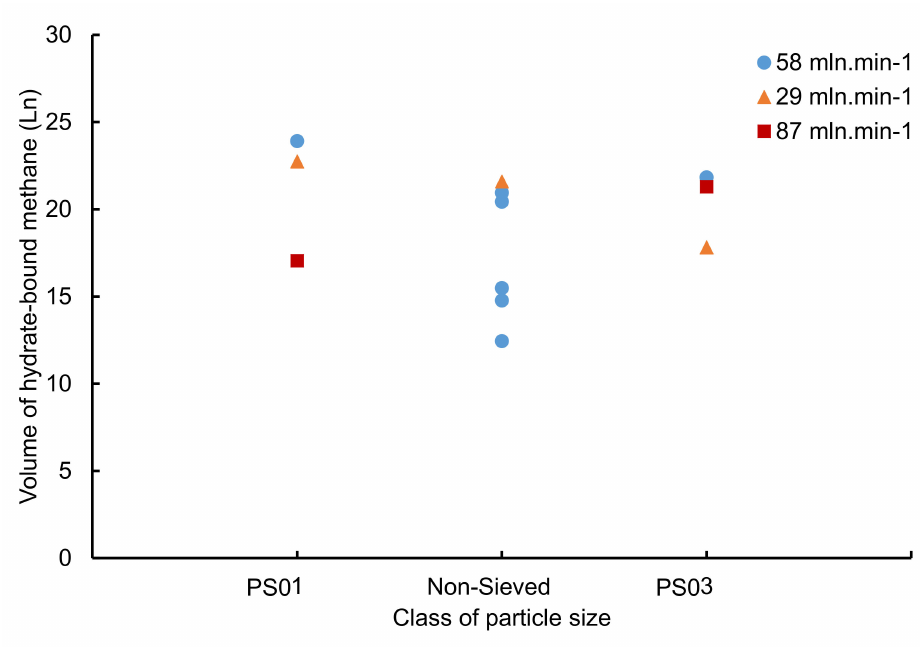
Figure 12. Volume of hydrate-bound methane as a function of particle size for a water saturation around 53% and di ff erent gas